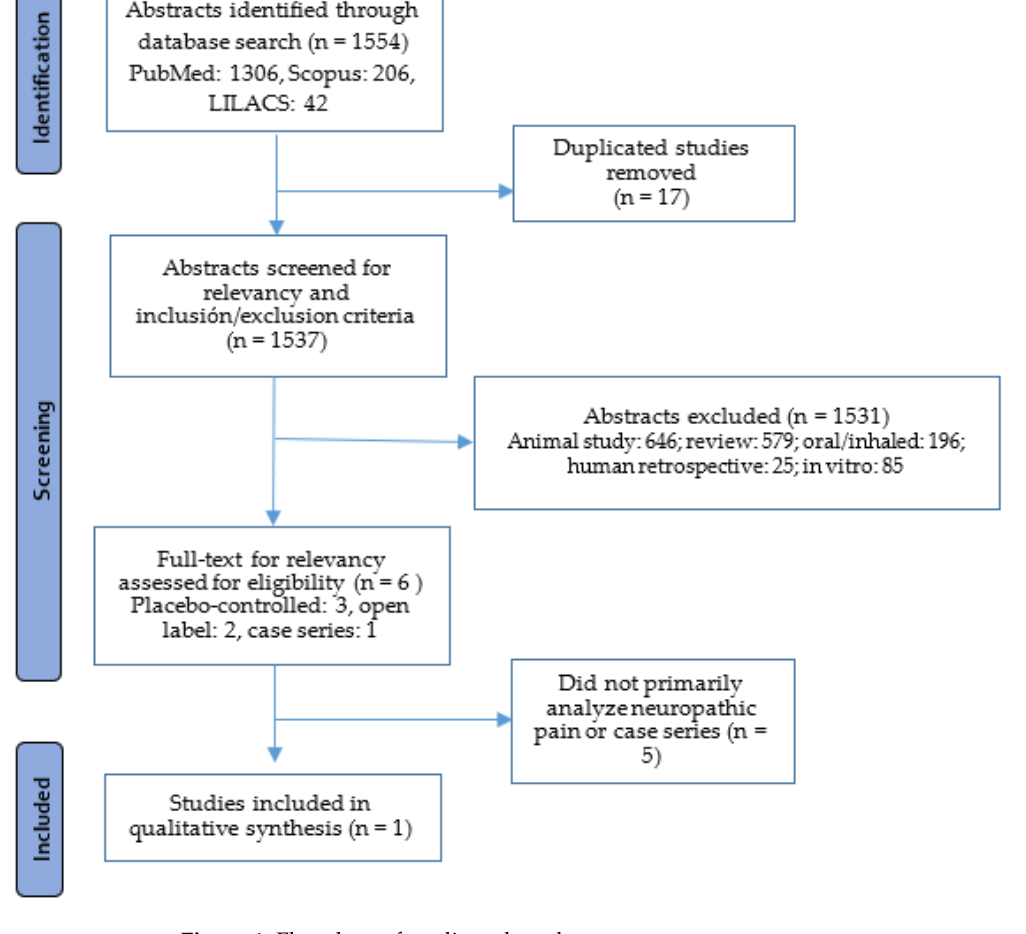
Figure 1. Flowchart of studies selected. Table 1. Description of study selected.